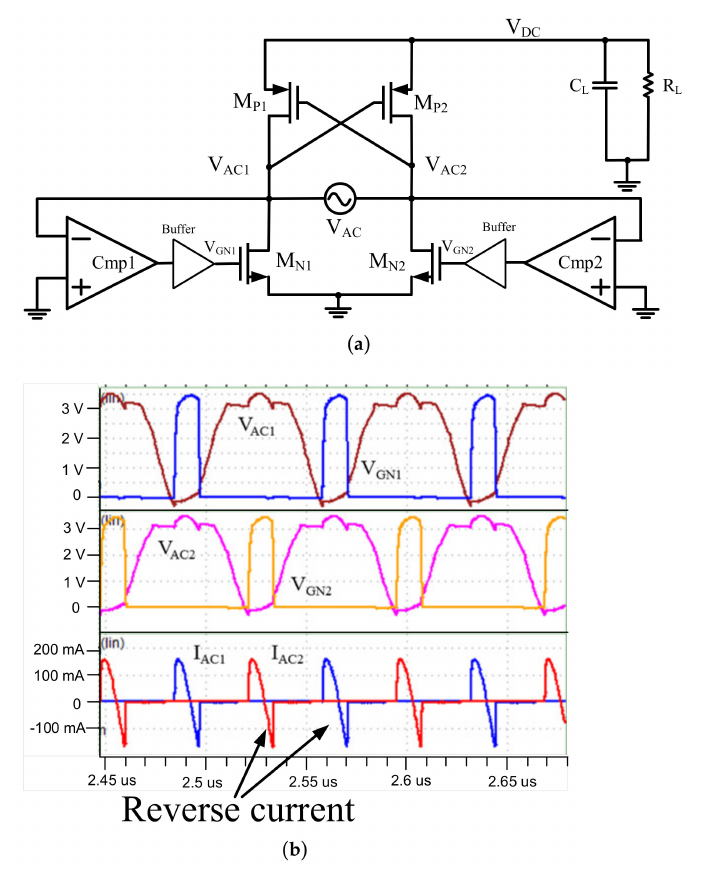
Figure 2. ( a ) Active rectifier without delay calibration circuit, ( b ) reverse current